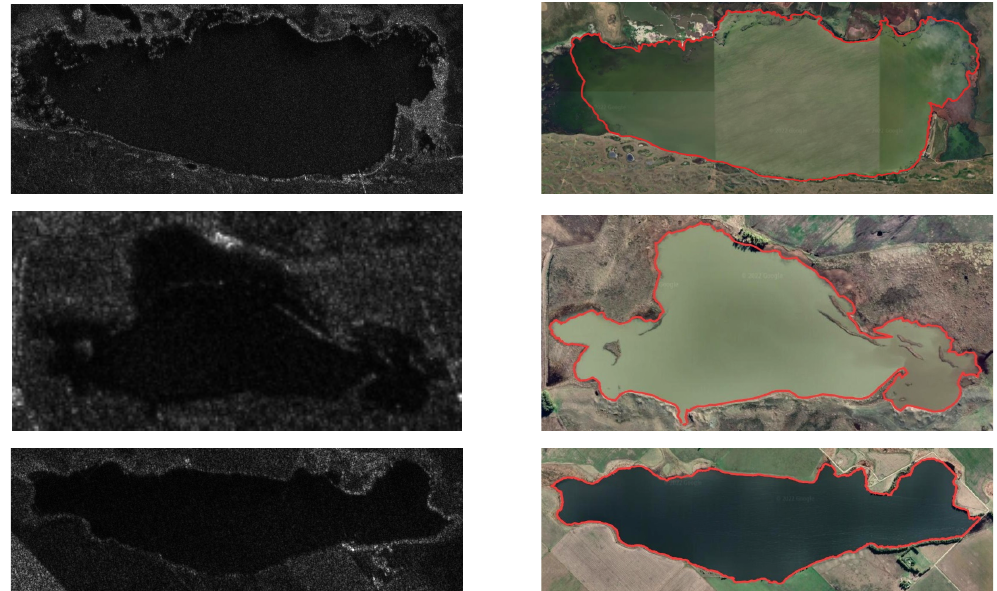
Figure 3. SAOCOM images of lagoons in the south of Buenos Aires, Argentina ( left ), and their true borders ( right ).